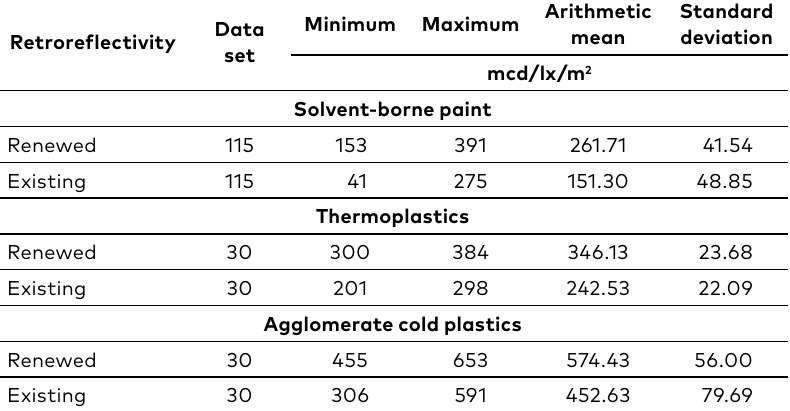
Table 2. Descriptive statistics of the measured values of road markings